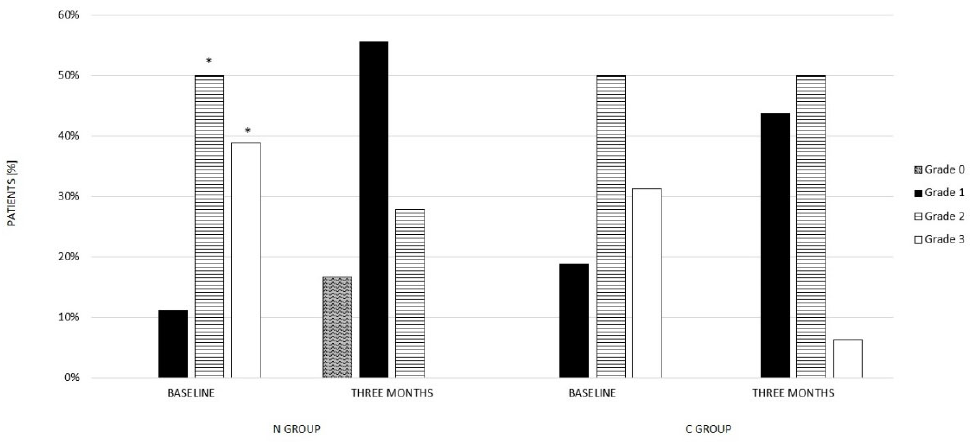
Figure 2. Ultrasound liver steatosis grade at baseline and after 3 months of treatment in N group and C group. Ultrasound liver steatosis grade: 0 = absent, 1 = mild, 2 = moderate, 3 = severe; * p < 0.05 vs. Three Months.